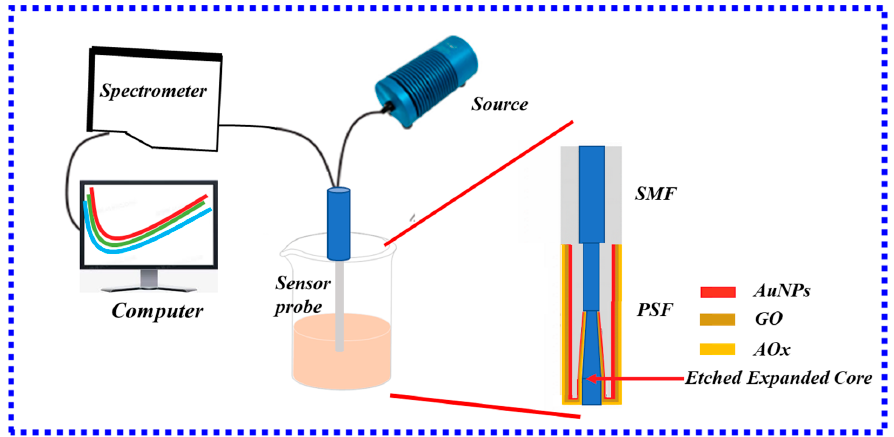
Figure 18. Schematic diagram of the experimental setup for measuring ascorbic acid.